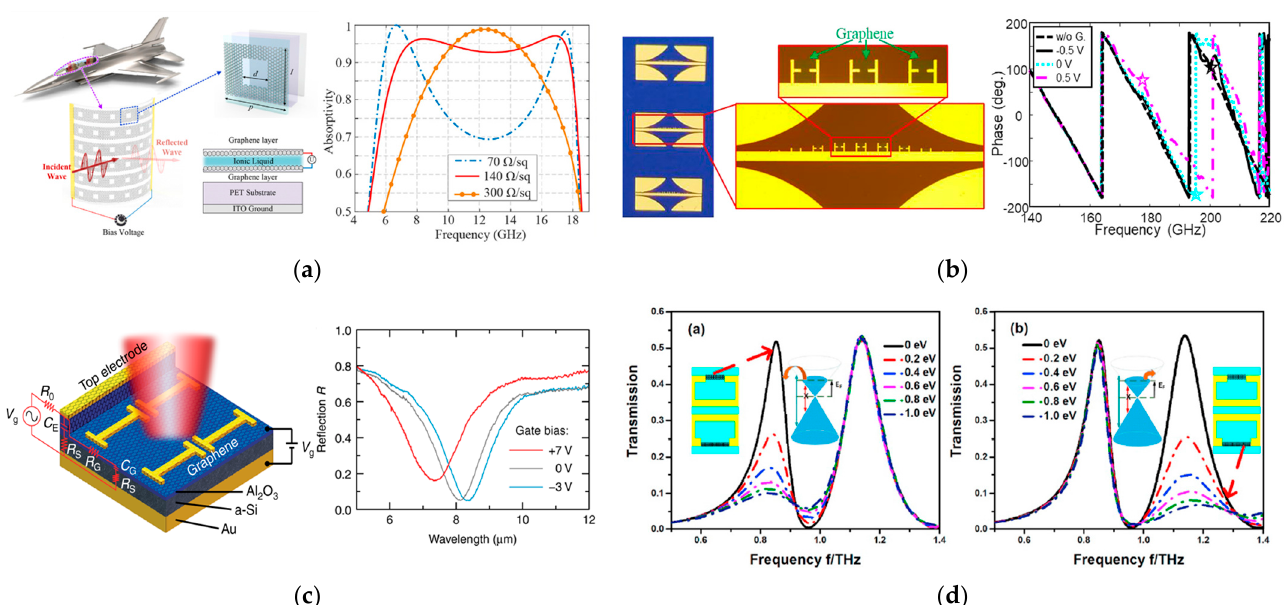
Figure 7. Active and programmable metasurfaces modulated with graphene. ( a ) Graphene metamaterial with adaptive absorption on transparent and flexible substrate at microwave frequencies [98]. Copyright Elsevier, 2021. ( b ) Hybrid surface plasmon polaritons with phase and frequency modulation controlled by graphene [123]. ( c ) Hybrid graphene metasurfaces for mid − infrared light modulation. Its modulation speed is as high as 1 GHz [96]. ( d ) Binary coding graphene − metal hy- brid surface at terahertz frequencies [130]. Copyright Elsevier, 2021.